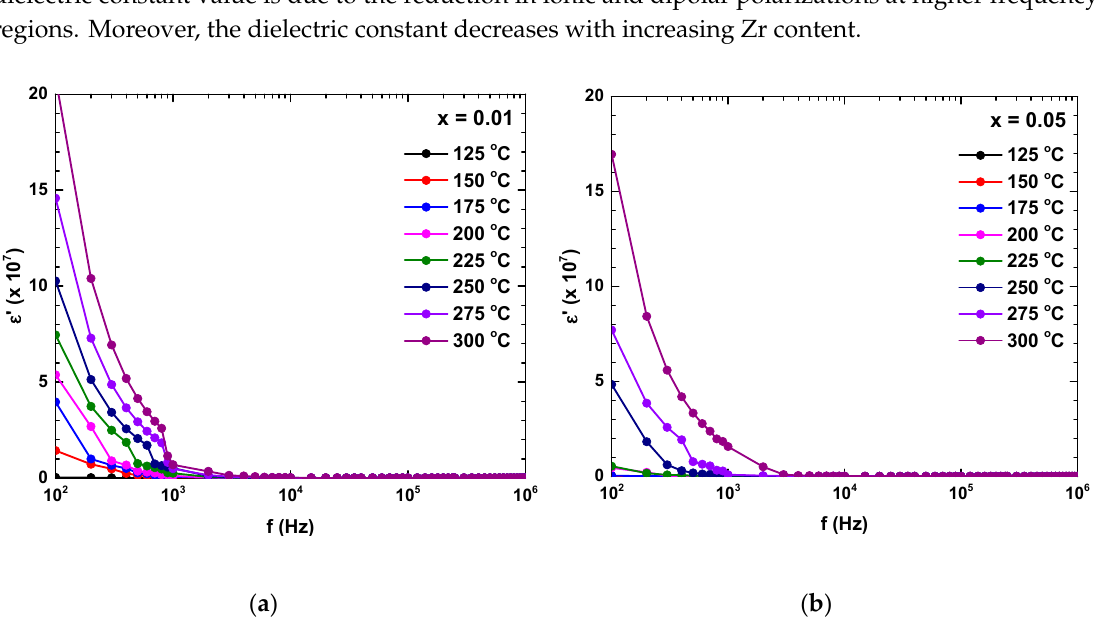
( b ) Figure 8. Dielectric loss, ε′ (cid:4593) (cid:4666)f(cid:4667), of LaFe 1-x Zr x O 3 with ( a ) x = 0.01 and ( b ) x = 0.05 annealed at 800 °C for 6 h at different temperatures. Figure 9 shows the complex conductivity for LaFe 1 − x Zr x O 3 ceramics. It is clear that the plot σ ( ω ) consists of two different regions: Ac conductivity, increasing with the frequency approximating to linear function, and dc conductivity, dominating in low frequencies. The frequency dependence of the complex conductivity followed the Jonscher’s power law [23]: (cid:2026)(cid:4666)(cid:2033)(cid:4667) = (cid:2026) (cid:3005)(cid:3004) + (cid:1827)(cid:2033) (cid:3046)